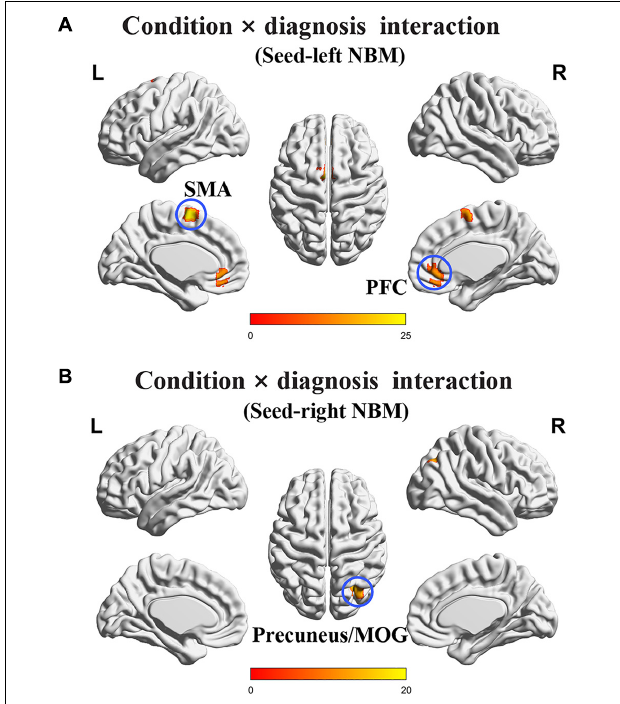
FIGURE 1 | The interaction regions of condition × diagnosis on rsFC of the NBM. (A) Based on the seed of left NBM, the interaction regions were primarily located in bilateral PFC and SMA. (B) Based on the seed of the right NBM, the interaction region was observed in the right precuneus/MOG. NBM, nucleus basalis of Meynert; PFC, prefrontal cortex; SMA, supplementary motor area; MOG, middle occipital gyrus. The statistical threshold was set at p < 0.005 with a cluster level of p < 0.05 (two-tailed, GRF corrected).